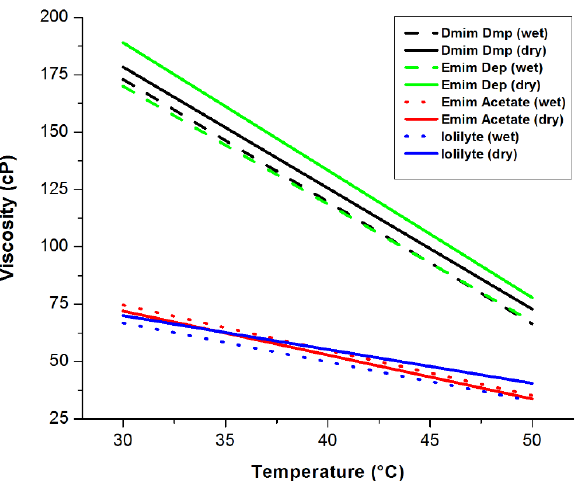
Figure 25. Viscosity measurements as a function of temperature of neat ionic liquids. Reproduced from [28].